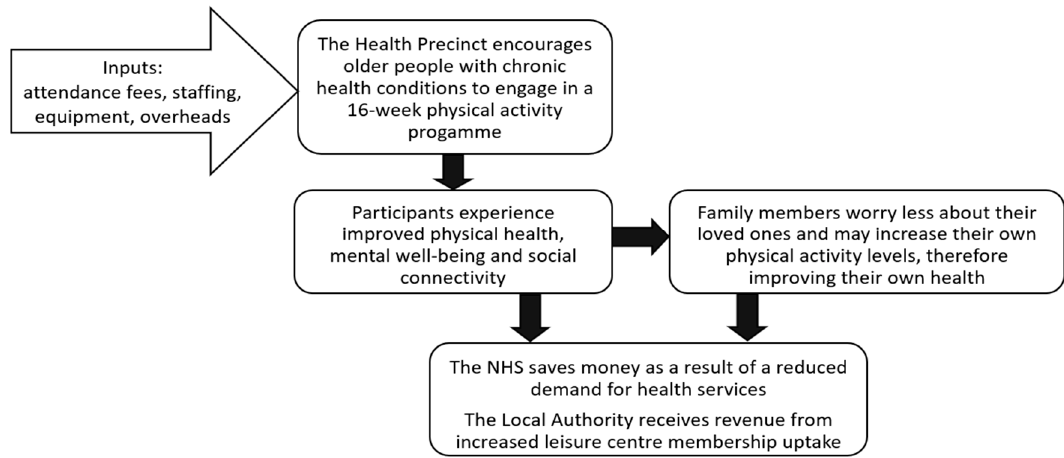
Figure 1. Overview of the theory of